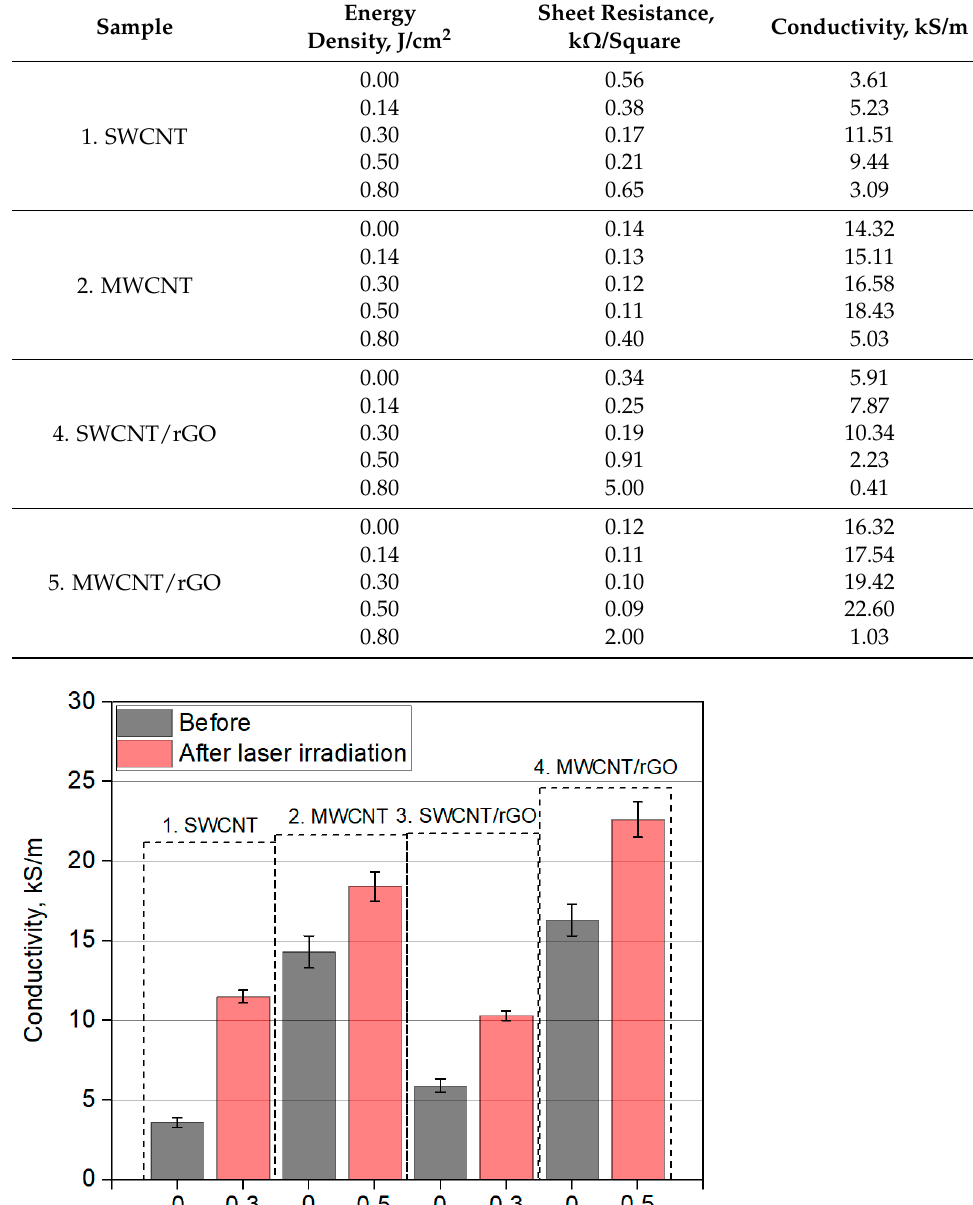
Table 3. Electrical conductivity of films based on SWCNT, MWCNT nanomaterials and their hybrids with rGO.